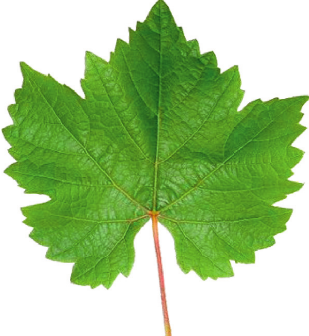
Figure 1: A typical vine leaf